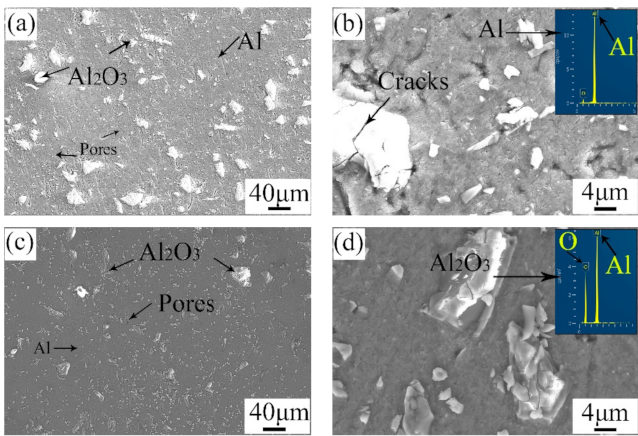
Figure 5. Microstructure of ( a , b ) the surface and ( c , d ) the cross-section of the repaired areas.